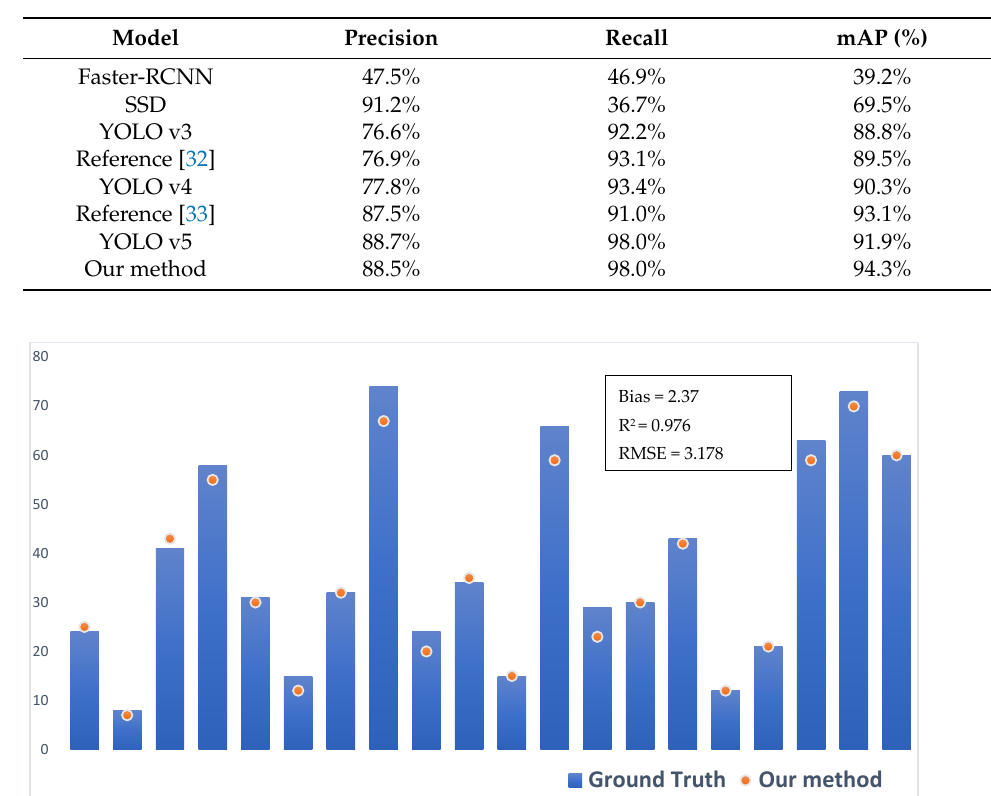
Figure 14. The comparison between the true value and the estimated value of a single image .